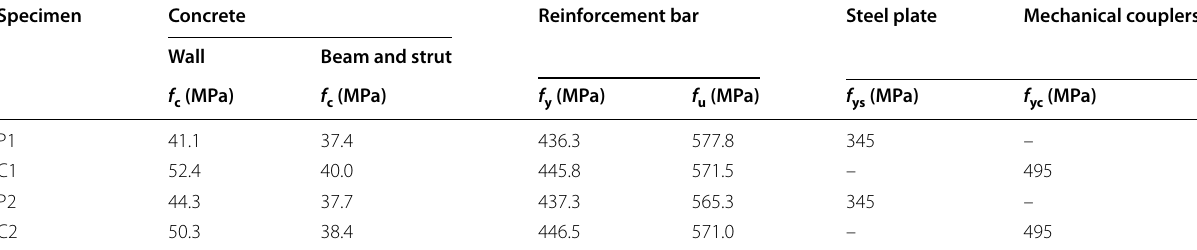
f c ; f y ; f u ; f ys ; and f yc are the cubic compressive strength of the concrete, yield strength of the rebar, ultimate strength of the rebar, yield strength of the steel plate, and yield strength of the mechanical coupler, respectively. The data in the above table are the average values of all measured data.